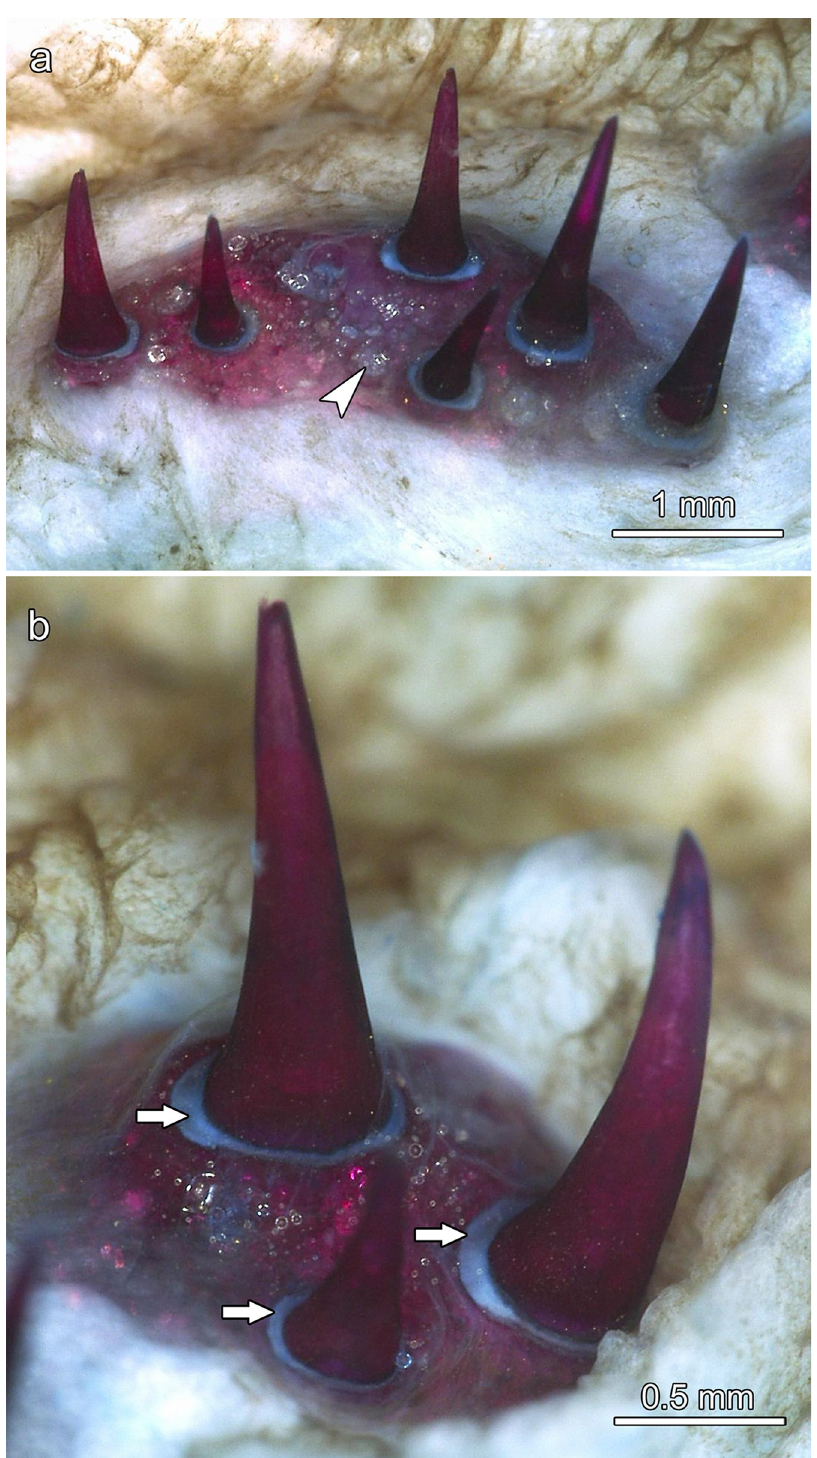
Fig 10. Tooth fields in the dorsal oropharynx of Anoplogaster cornuta , cleared and stained (Alizarin red S, alcian blue 8 GX) specimen. (a) Tooth field on the right ectopterygoid, note empty tooth locus (arrowhead). (b) T ooth field on the right entopterygoid. Note ring-like collagenous tissue (arrows in b) connecting the tooth base to the dentigerous bone.